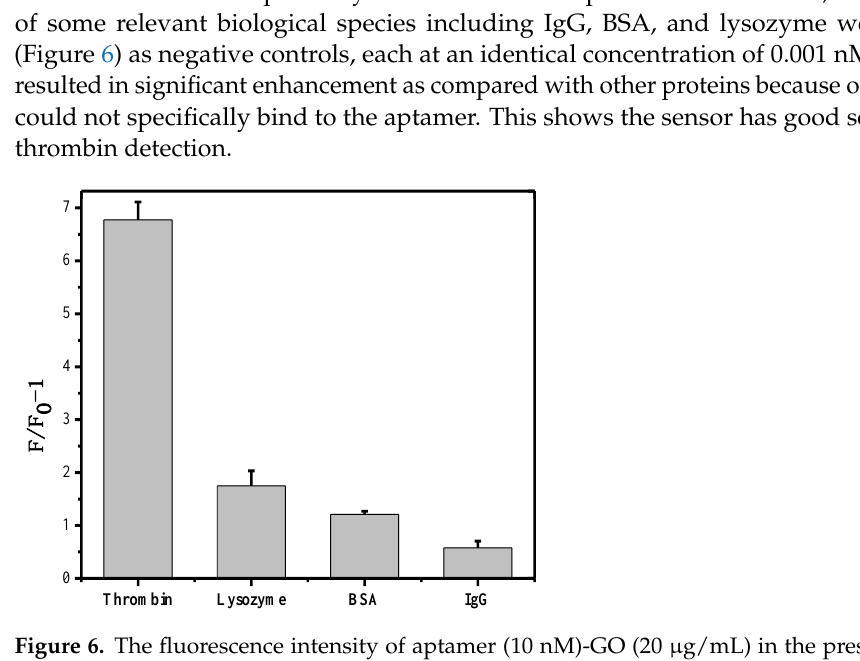
Table 2. Different methods for thrombin detection based on aptamer sensors.